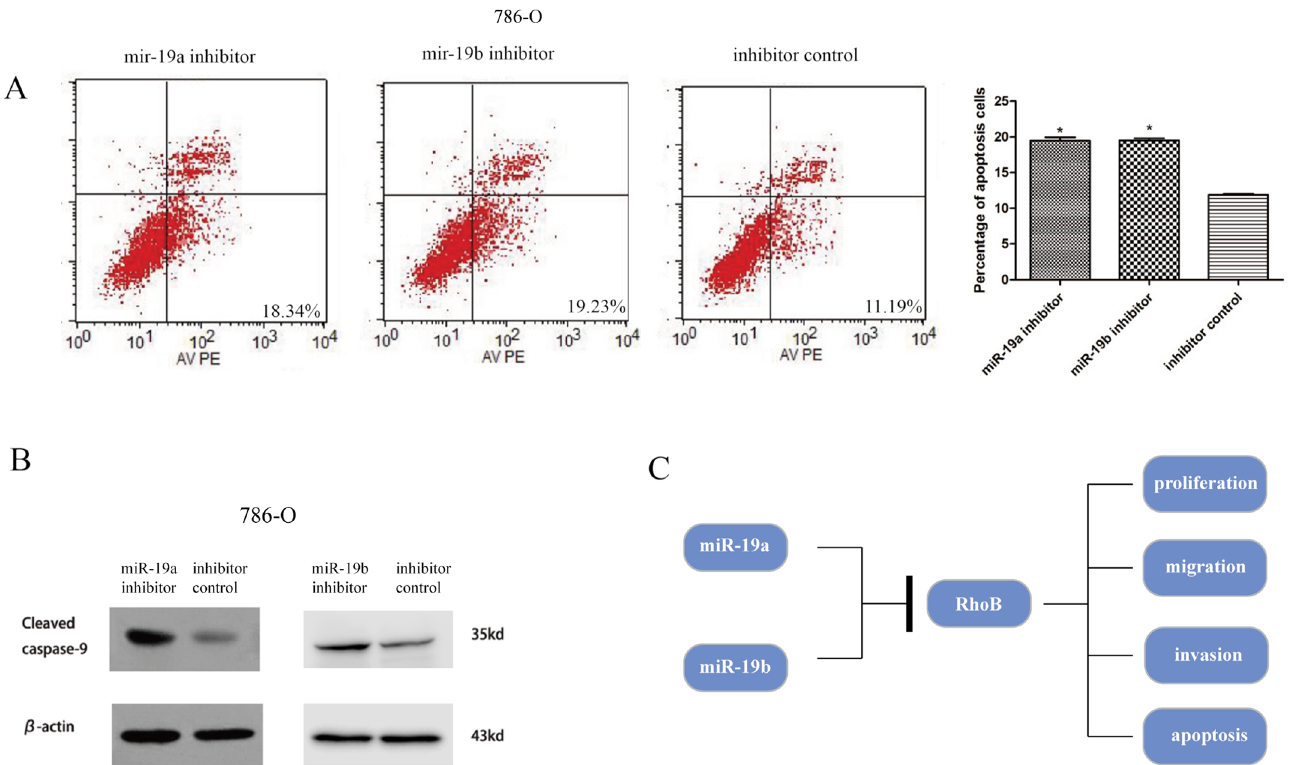
Fig 5. MiR-19a and miR-19b inhibitors induce cell apoptosis. (A) Flow cytometry results of Annexin-V5 analysis in 786-O cells transfected with miR-19a and miR-19b inhibitors. An inhibitor control was included as a negative control. Graphs showing changes of the apoptotic percentage of the cells (left); quantification of relative apoptosis (right). The data represent the means ± S.D. from three independent experiments performed in triplicate. (cid:3) Significant differences from control oligo-transfected cells (P < 0.05) (B) Western blot results showing the effect of miR-19a and miR-19b inhibitors on the expression of cleaved caspase-9 in 786-O cells. (C) Potential mechanism showing the effect of the negative regulation of RhoB by miR-19a/b on the proliferation, migration, invasion and apoptosis of